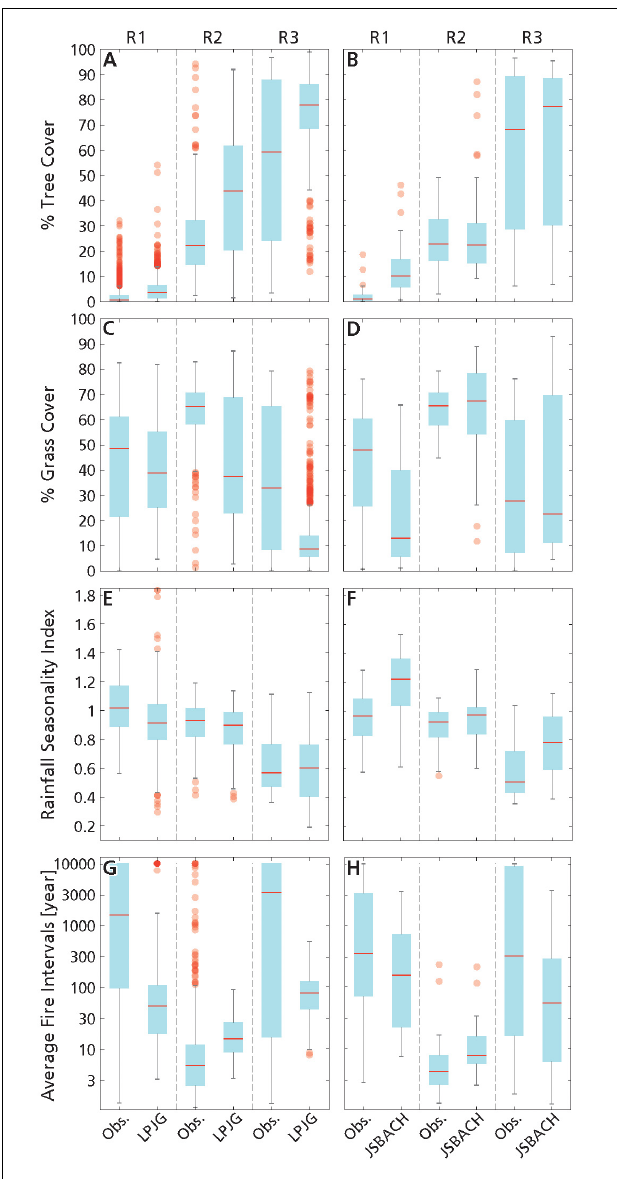
FIGURE 5 | Box plots of vegetation cover and abiotic variables in the three mean annual rainfall ranges: (A,B) percentage tree cover, (C,D) percentage grass cover, (E,F) rainfall seasonality index, (G,H) average fire intervals (in logarithmic scale) from obs. 0.5 ◦ and LPJ-GUESS (left column) and from obs. 1.875 ◦ and JSBACH (right column). Vertical lines delimit the ranges of low MAR (R1: MAR ≤ 590 mm year − 1 ), intermediate MAR (R2: 590 mm year − 1 < MAR < 1200 mm year − 1 ) and high MAR (R3: MAR ≥ 1200 mm year − 1 ). Red lines are the medians. The top and bottom of each box are the 25th and 75th percentiles, respectively. The extremes of the whiskers correspond to the highest and lowest values within a range defined by the 75th and 25th quartiles +/–, respectively, 1.5 times their interquartile range. Red symbols are